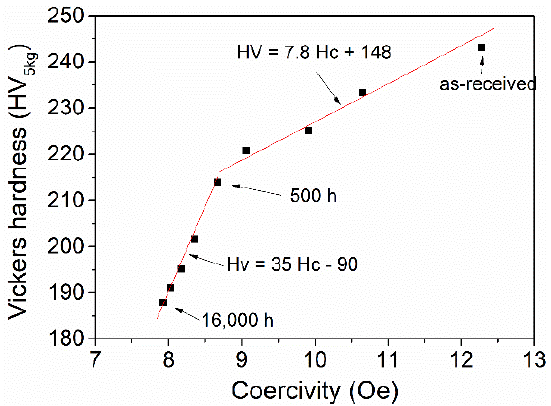
Figure 8. The relation between Vickers hardness and coercivity in the present steel with different age durations.